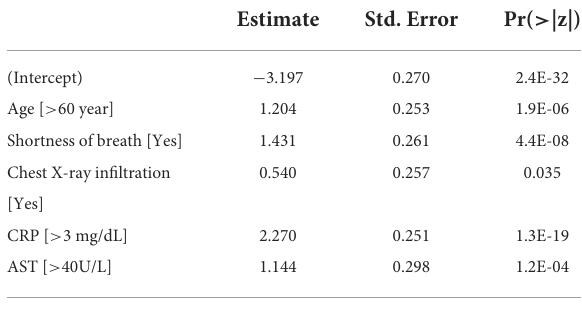
TABLE 5 Fitted results of the logistic regression model for the Below Moderate vs. Above Severe model and Below Severe vs. Critical model. (A) Binary outcome: Below moderate vs. above severe Estimate